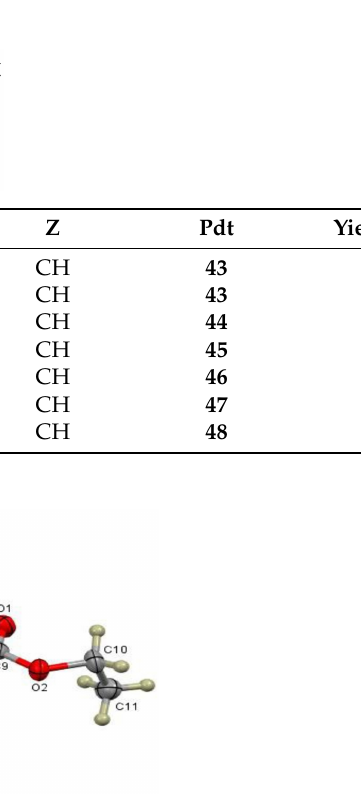
Figure 2. X-ray structure for product 49 (CCDC 2246638) from reaction of 32 with